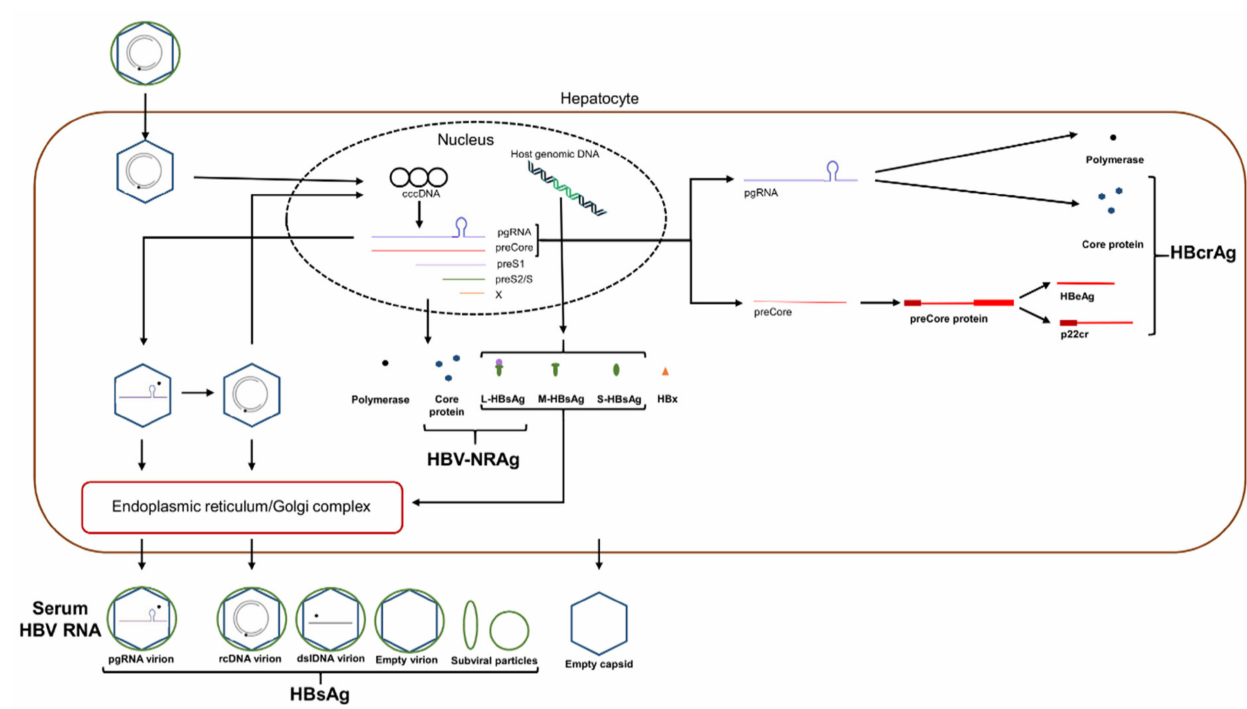
Figure 1. Overview of the HBV infection and replication cycle. Infecting virion particles are transported to the hepatocyte nucleus to release the relaxed circular partially double-stranded DNA genome, associated with the viral polymerase, into the nucleus. The genome is repaired and converted into cccDNA, which is the template for viral mRNA synthesis. The viral transcripts are translated following transport to the cytoplasm. The three surface antigen proteins are membrane specific and compose the viral envelope in conjunction with host lipid. Within the cytoplasm, pregenomic RNA (pgRNA) is encapsidated together with newly expressed polymerase protein within spontaneously formed capsid particles composed of core protein, to form the viral replication complex. pgRNA also serves as the template for the expression of the polymerase and core proteins. The HBV biomarkers discussed in this review, other than qAHBc, which is produced following the humoral immune response to core antigen, are shown within their expression pathways and their component parts. Note that HBsAg is detectable from replicative and non-replicative virion particles, as well as subviral particles and HBsAg expressed from HBV DNA integrated into host genomic